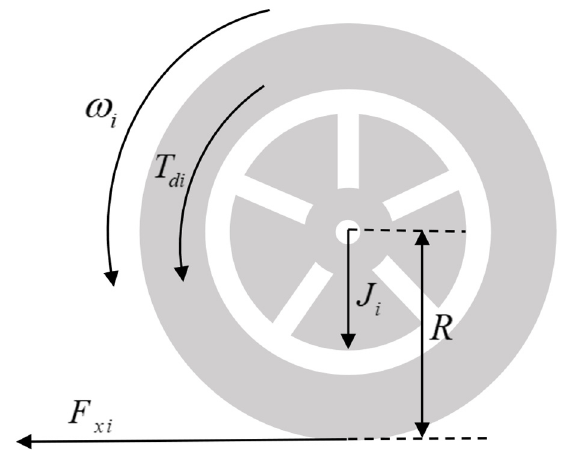
Figure 3. The wheel dynamics model.